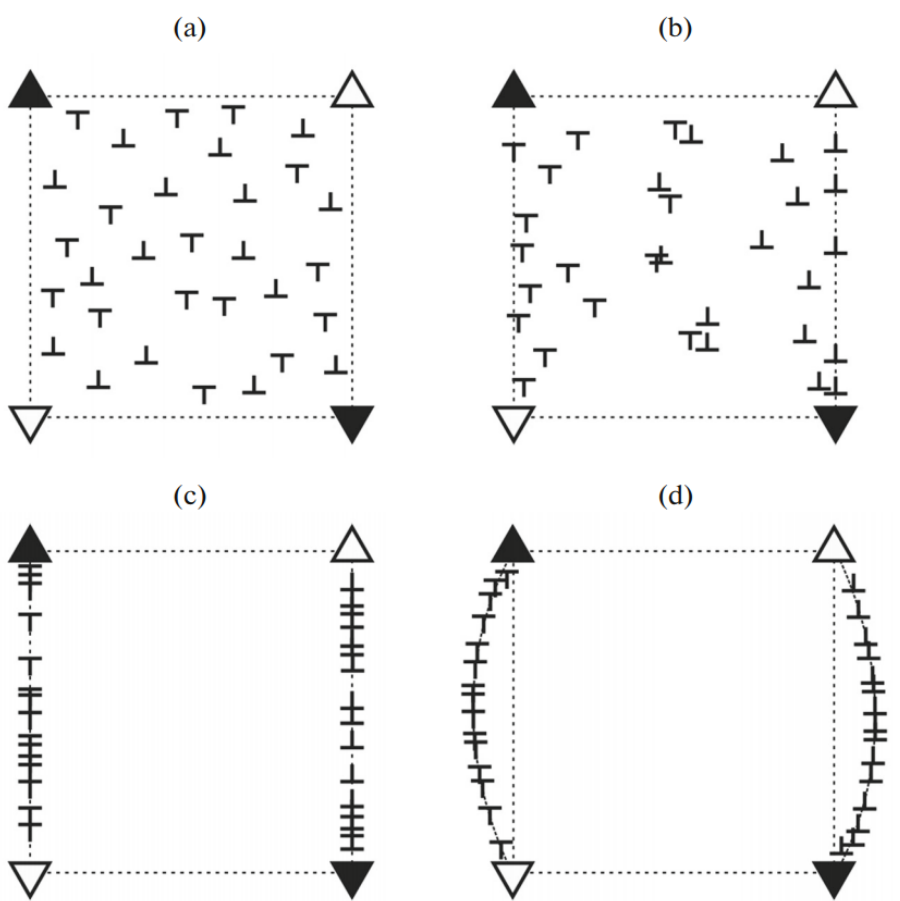
Figure 17. Configurations of a dislocation system in a model square grain with junction disclina- tions: ( a ) initial configuration; ( b ) intermediate stage of UST; ( c ) final state after UST in the case of impenetrable boundaries; ( d ) the same in case of transparent boundaries [112].